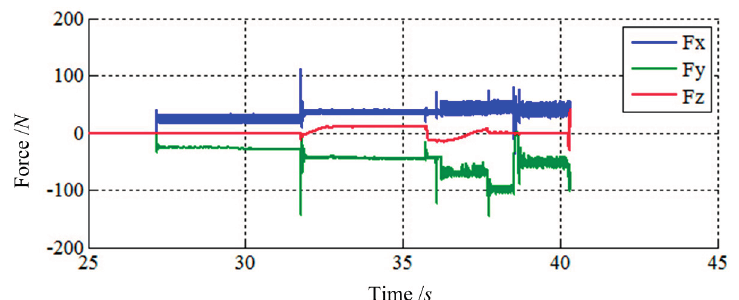
Figure 11. The force tracking results of Case 1.